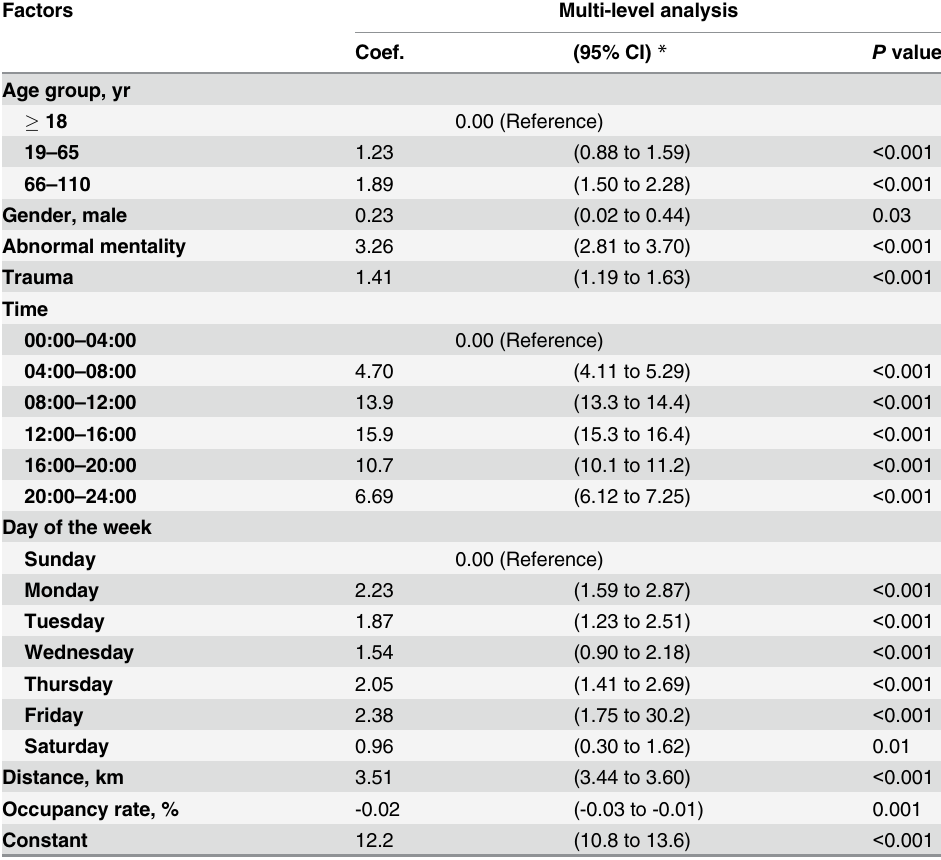
Table 2. Linear regression analysis with a multi-level regression